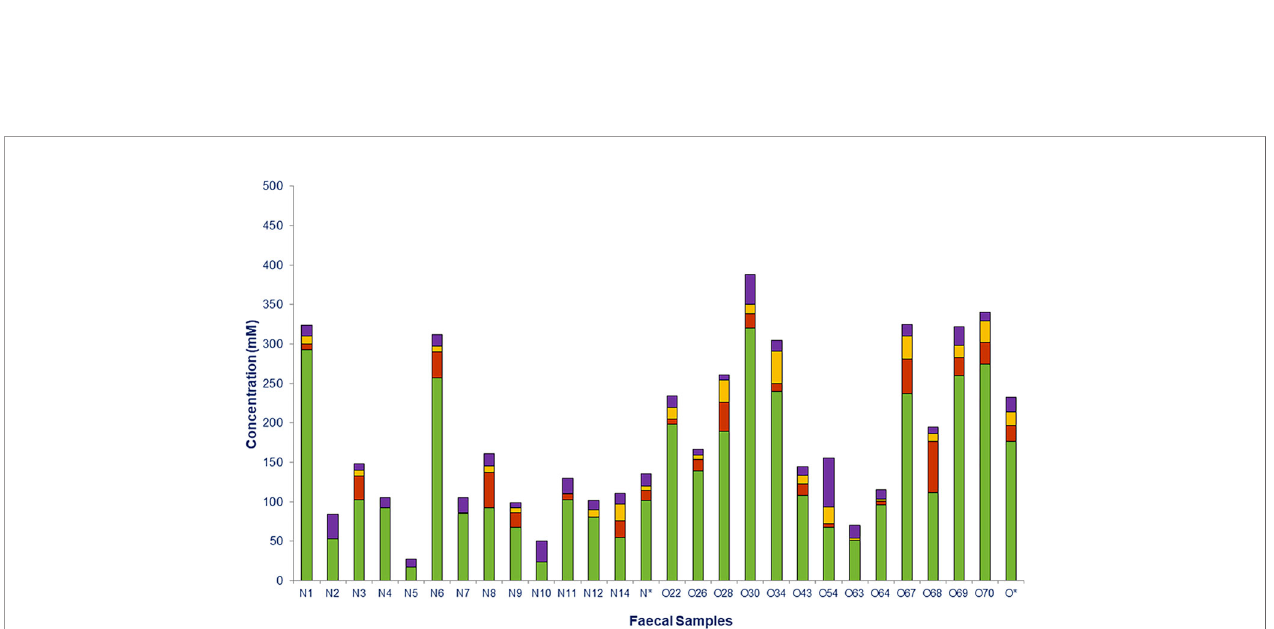
FIGURE 6 | Short chain fatty acids (SCFAs) and lactate measured in fecal samples from normoweight (N) and obese (O) individuals: acetate ( ), propionate ( ), ■ ), and lactate ( ). The column (*) represents the median value of each butyrate (